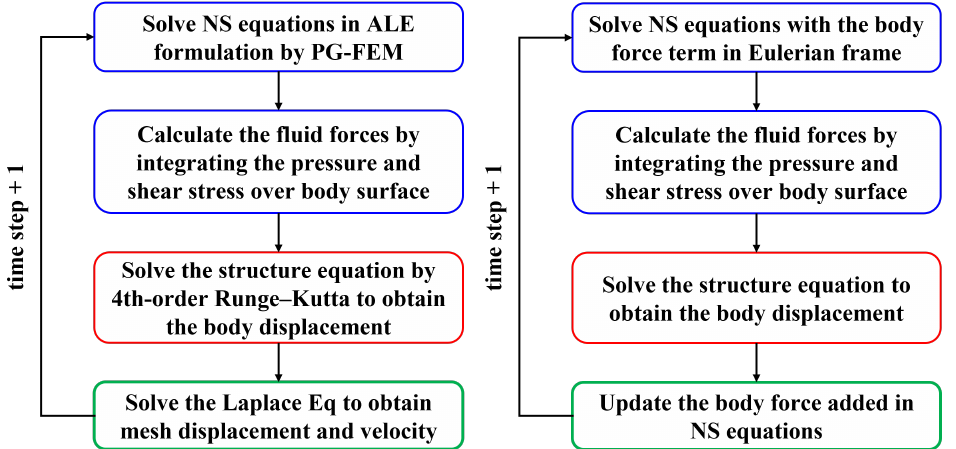
Figure 8. Numerical computational procedure for the simulation of FIV of a bluff body using the ALE algorithm for a moving mesh scheme (left panel) and the immersed boundary method for a fixed mesh scheme (right